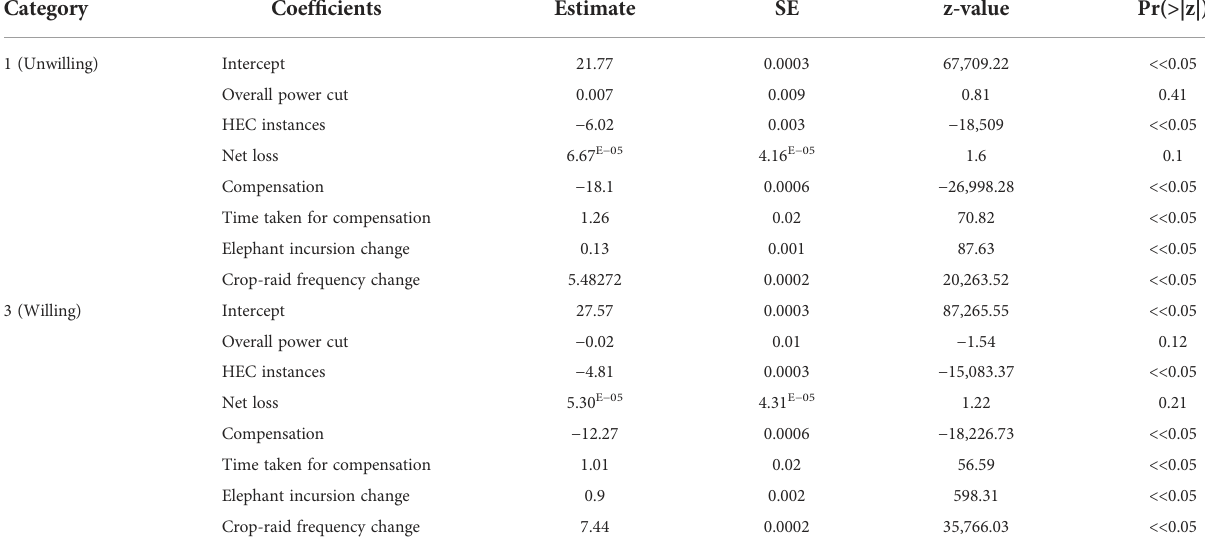
TABLE 6 Table representing estimates and level of signi fi cance of best fi t multinomial logistic regression for describing the relationship with predictor variables and categorical variable of willingness to pay ( “ 2 ” = true zero, as the reference category) on the non-barrier sites.